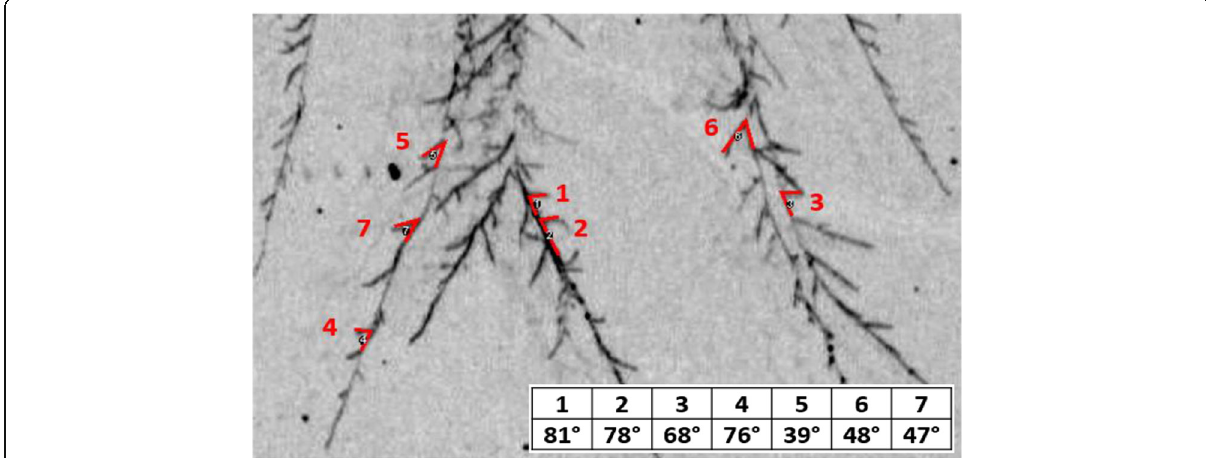
Fig. 8 Manual indication of branching angles on R. solani hyphae at 20 °C and 75% RH. Branching angles are highlighted and calculated with ImageJ (Schindelin et al.